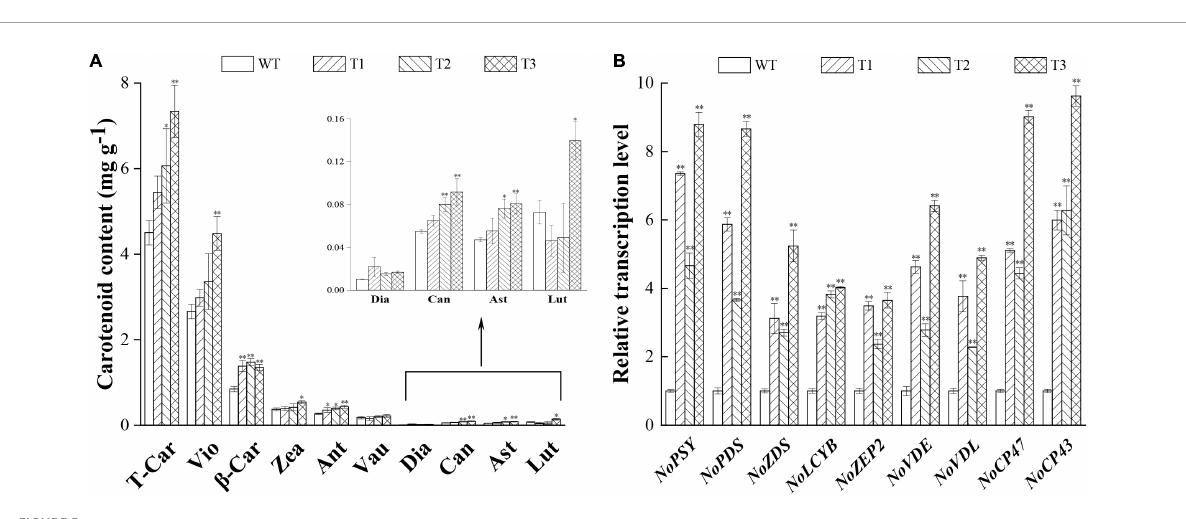
FIGURE5 Comparison of carotenoid content and relative mRNA abundance between WT and transformants. (A) Carotenoid content of WT and transformants. (B) Transcription levels of the key genes. T-Car, total carotenoid content; Vio, violaxanthin; β -Car, β -carotene; Zea, zeaxanthin; Ant, antheraxanthin; Vau, vaucheriaxanthin; Dia, diadinoxanthin; Can, canthaxanthin; Ast, astaxanthin; Lut, lutein. * and ** indicate a significant ( p < 0.05) and highly significant ( p < 0.01) differences,